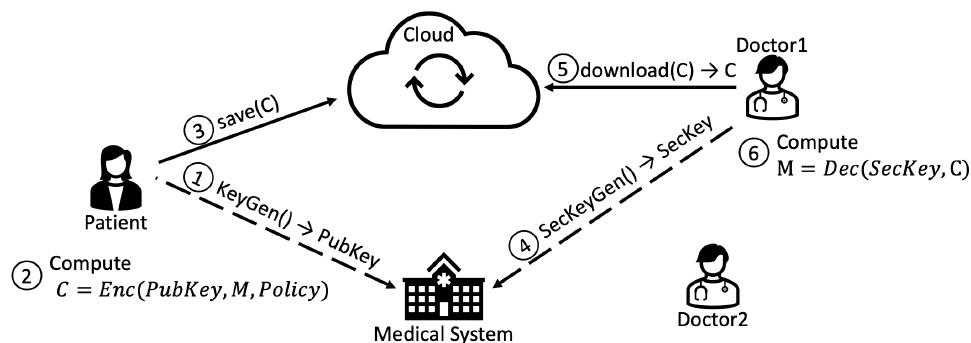
Figure 8. ABE-based data protection and